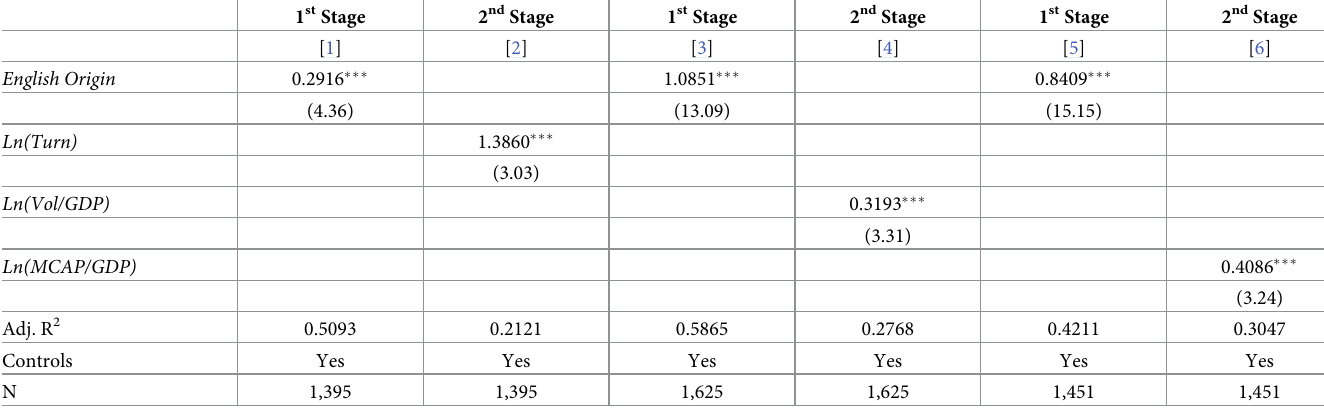
Table 7. Pharmaceutical innovation and equity market development–Instrumental variable